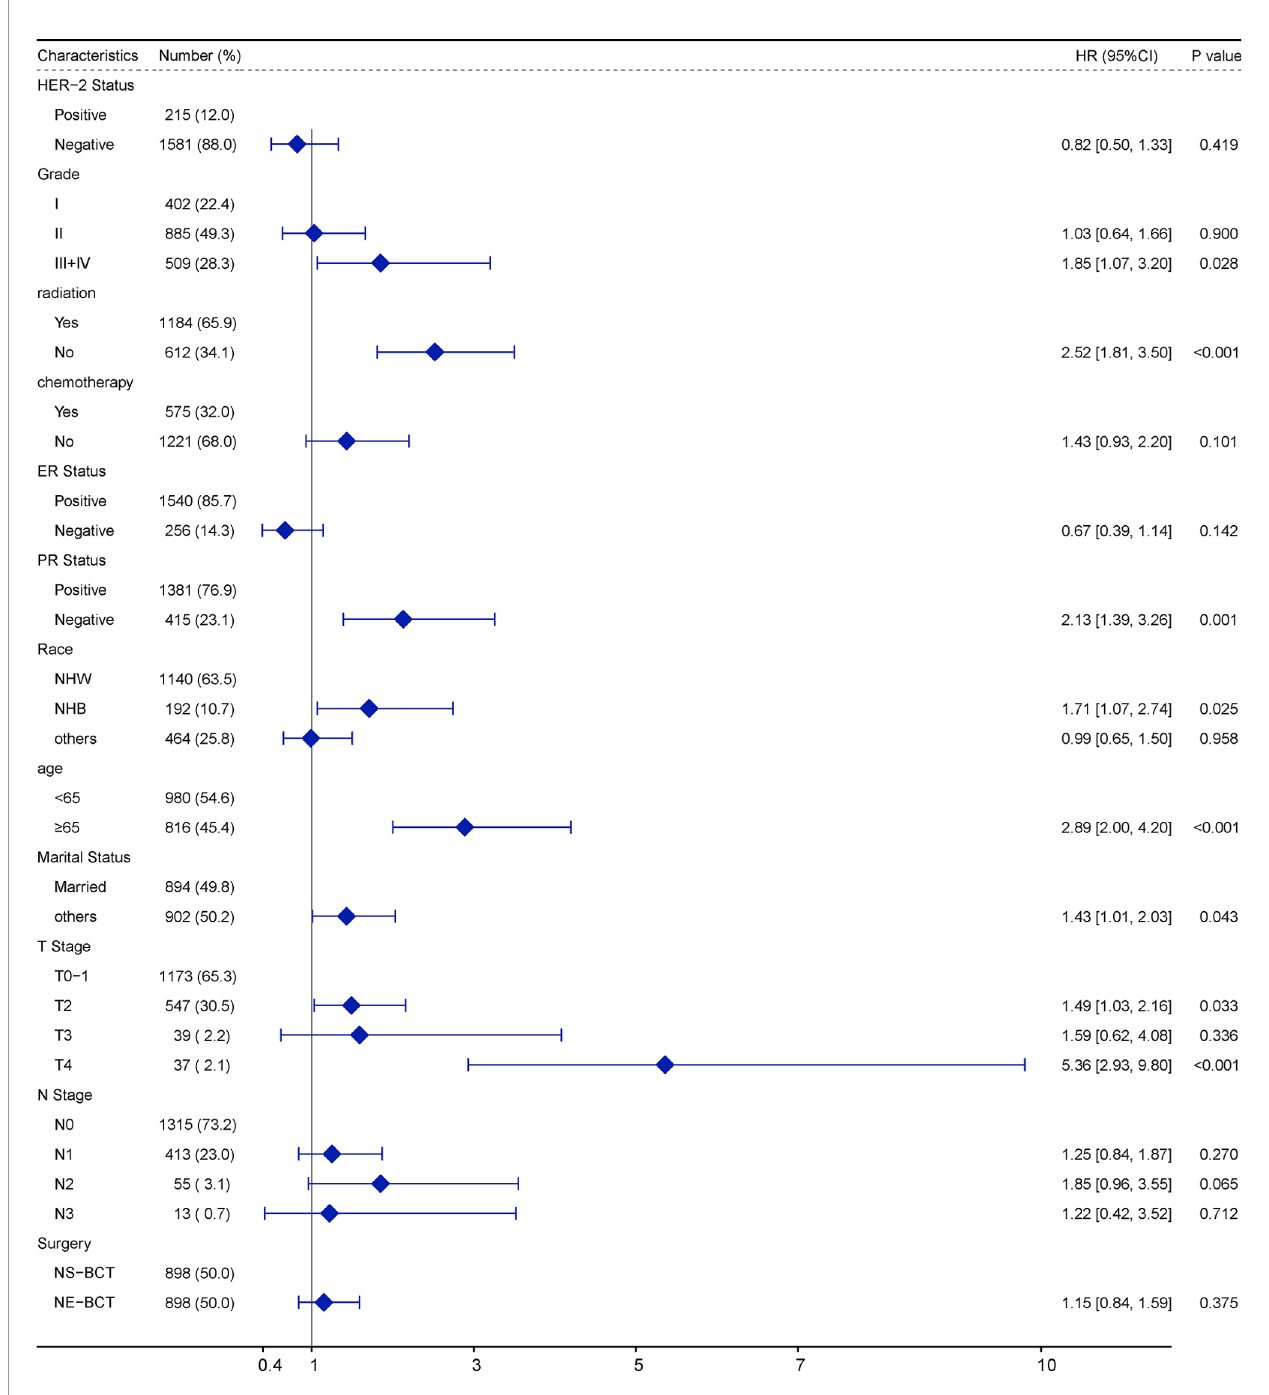
FIGURE 6 | Multivariate Cox regression model forest graph between 2010 and